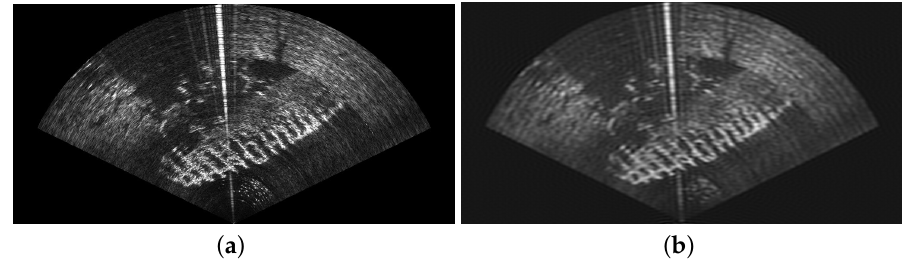
Figure 6. ( a ) The unfiltered sonar image. ( b ) The sonar image after using a low-pass